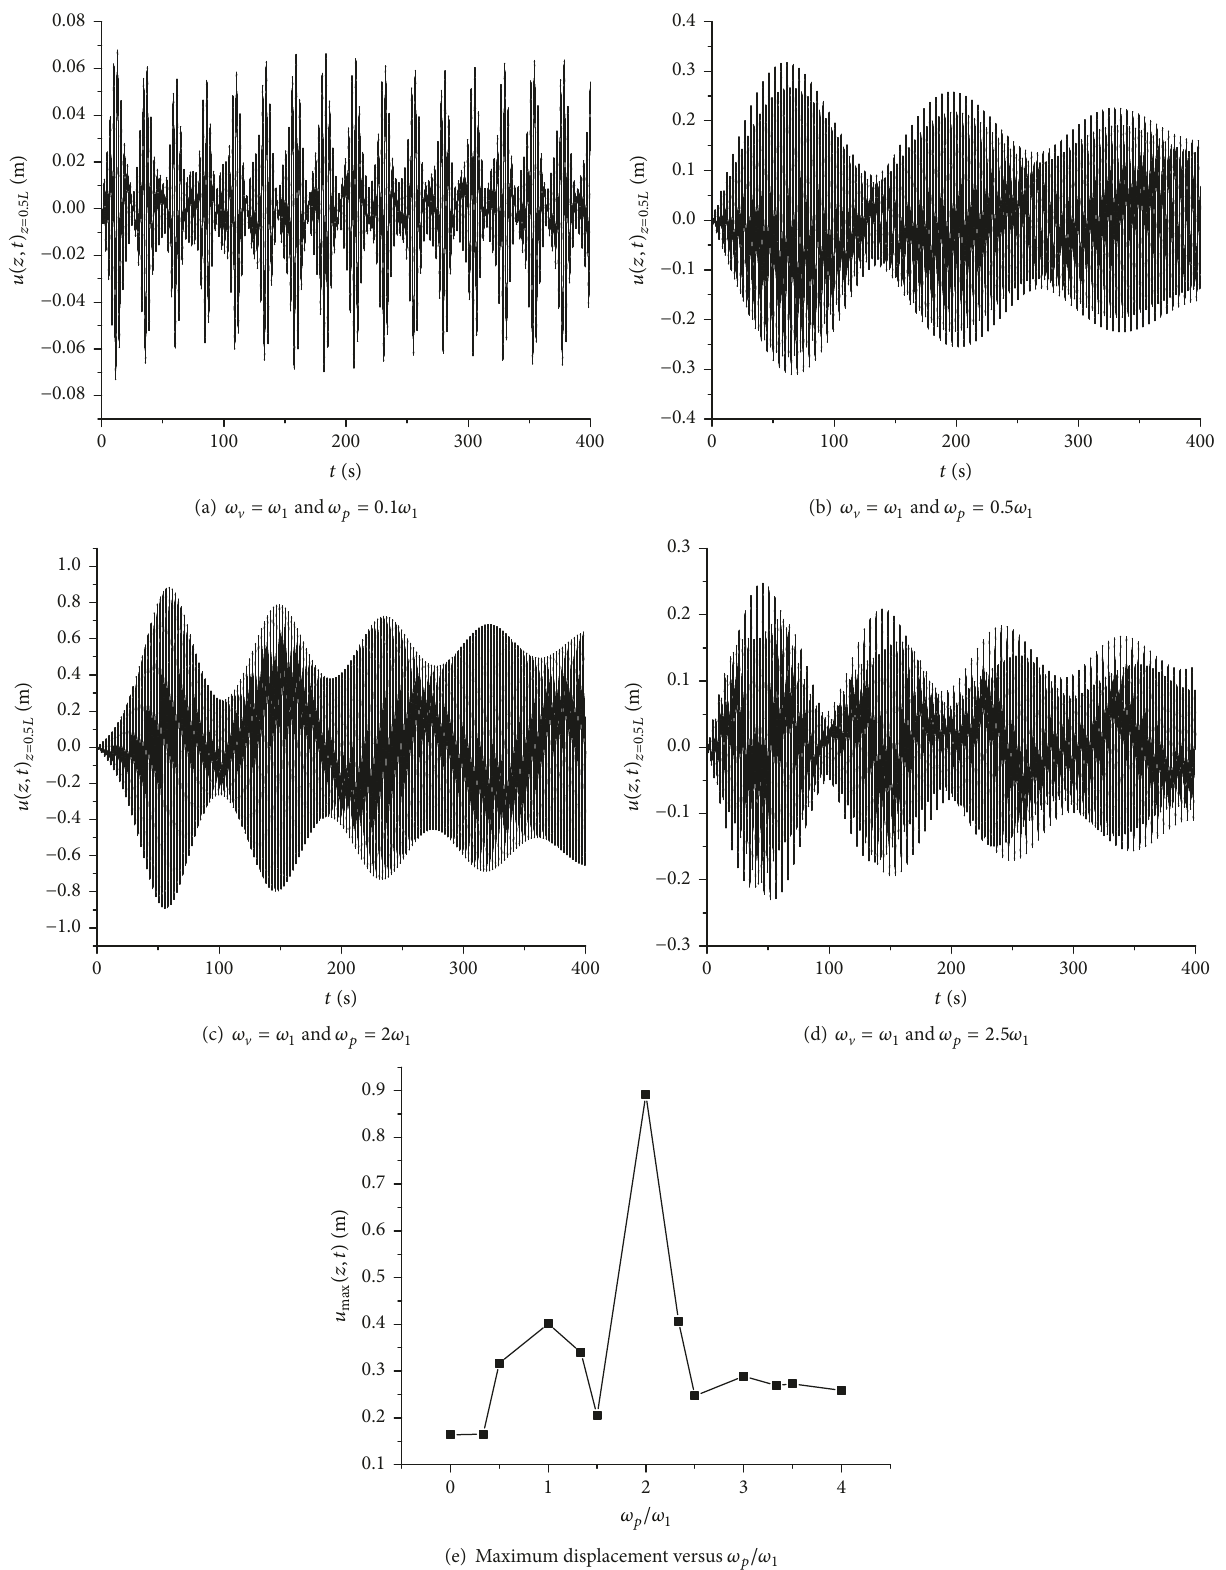
Figure 7: Dynamic response of the cable under combinations of vortex excitation and parametric